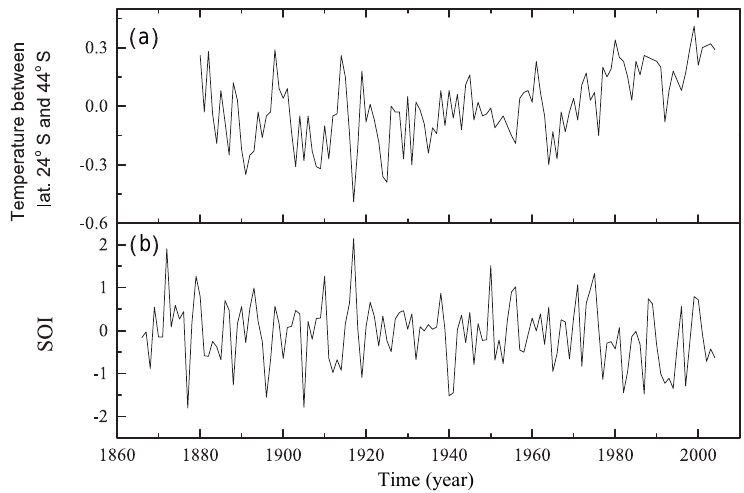
Figure 2. (a) Annual mean temperature anomaly between 24 and 44 ◦ S. (b) Southern Oscillation Index